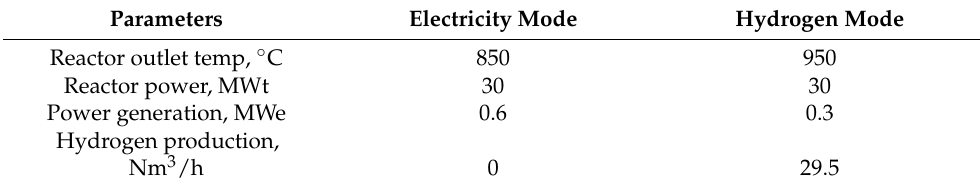
Table 2. HTTR-GT/H 2 operational modes (data reproduced from